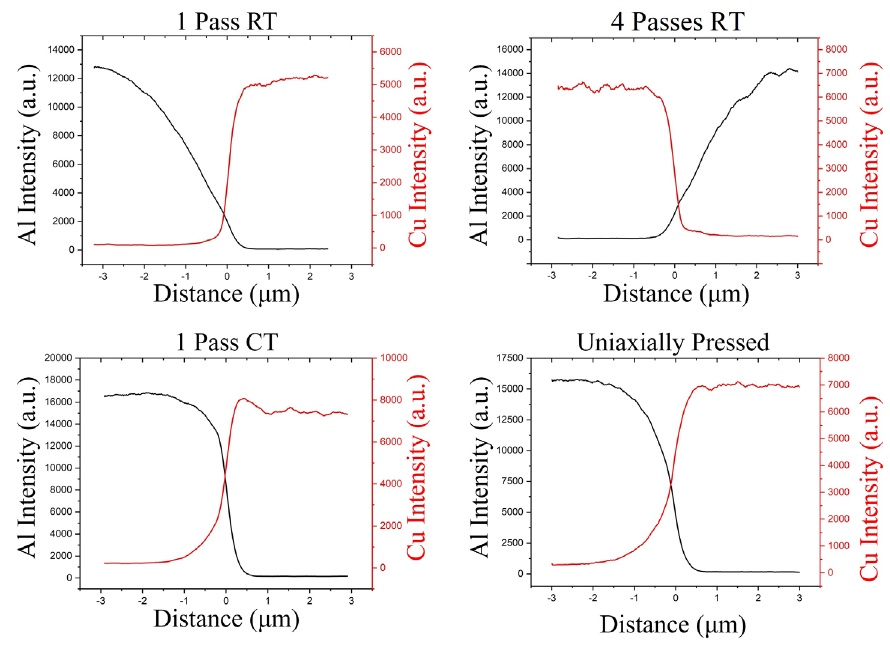
Figure 8. SEM-EDX line scans for the interface between Al and Cu particles on different samples. The location of the line scans is displayed by red lines in the first column of Figure 7.